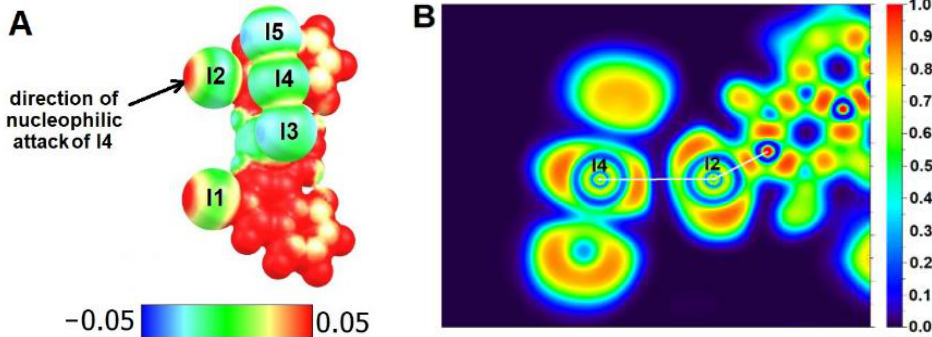
Figure 7. ESP distribution mapped on the 1.1 × van der Waals surface for M1 ( A ) and ELF for BM1 2 ( B ).